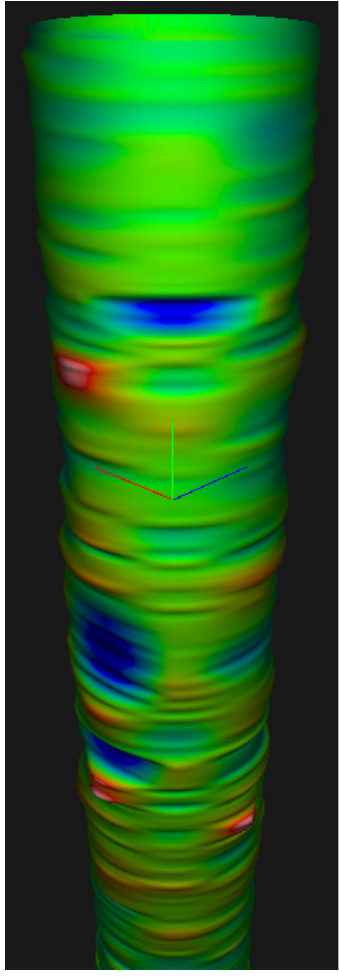
Figure 15. Well model in color.